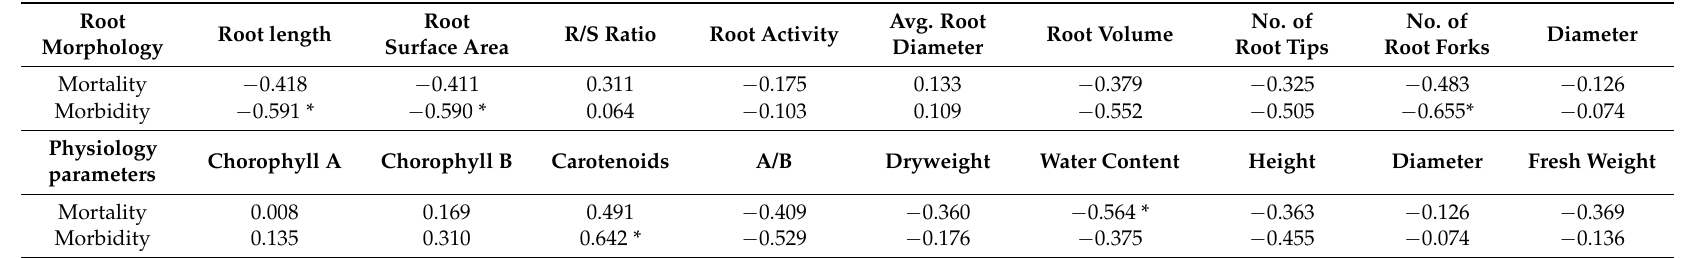
Table 4. Pearson correlation coefficients (r) of variables with mortality and